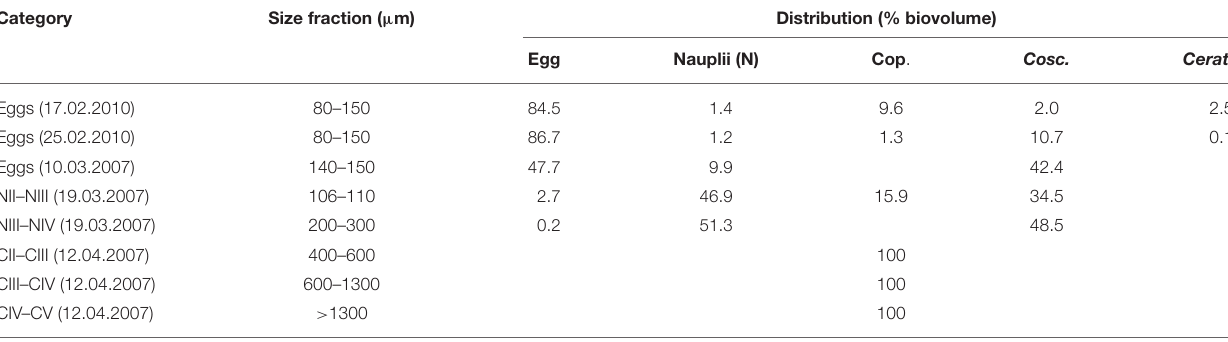
TABLE 1 | Size fractions and the percent distribution by biovolume for the fractions selected for fatty acid analysis. Category Size fraction ( µ m)